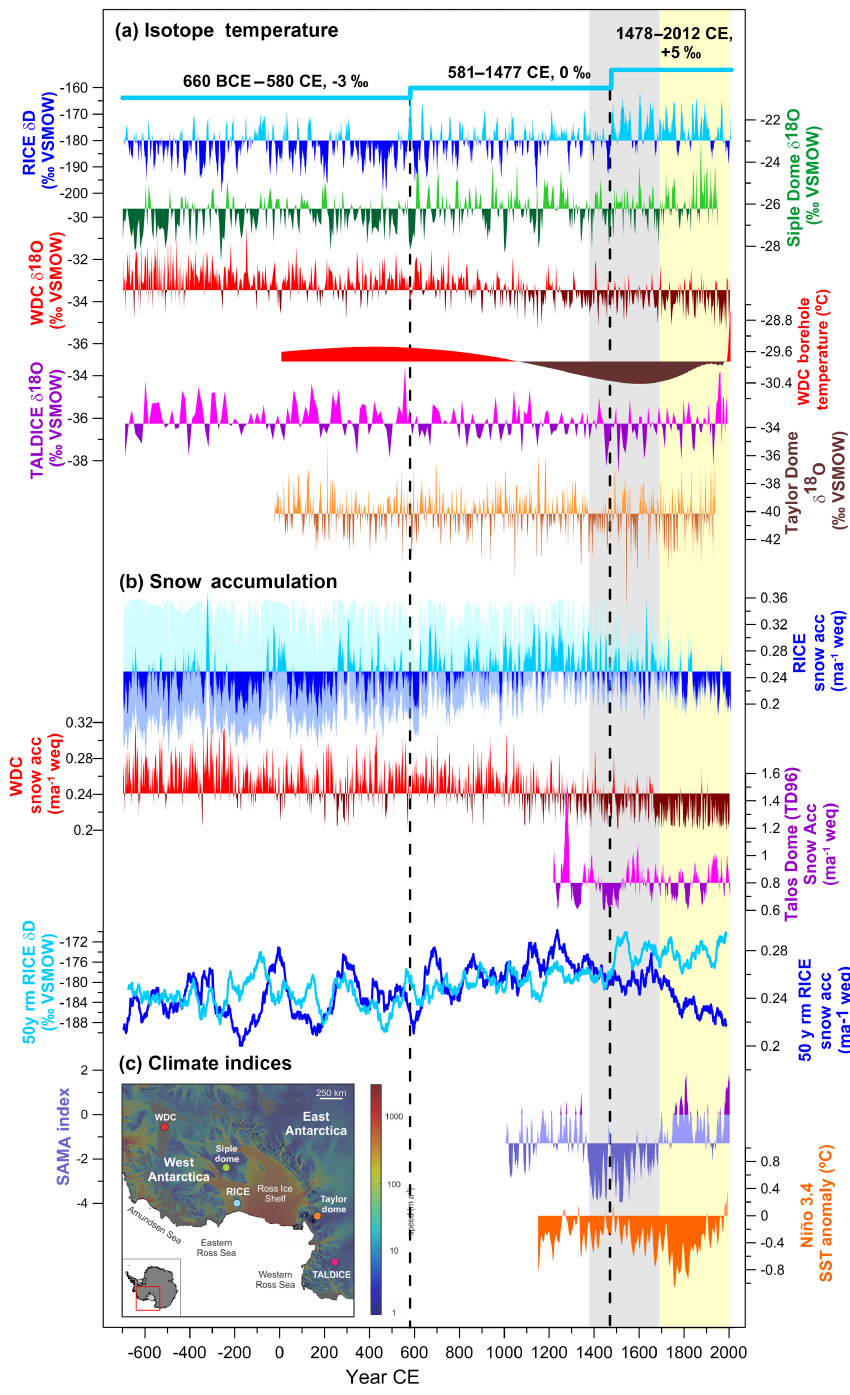
Figure 6. (a) Isotope records for the past 2700 years for RICE, Siple Dome (Brook et al., 2005), WDC (WAIS Divide Project Members, 2013), TALDICE (Stenni et al., 2011) and Taylor Dome (Steig et al., 1999, 2000; Sigl et al., 2014; PAGES2k Consortium, 2017); (b) snow accumulation data for RICE (Winstrup et al., 2017), WDC (Fudge et al., 2016) and Talos Dome (TD96). No snow accumulation data are available for Siple Dome or Taylor Dome; (c) reconstructions of climate indices for SAM A (Abram et al., 2014) and Niño 3.4 based on HadSST2 (Emile-Geay et al., 2013). Colour coding identifies above- and below-average values. Grey shaded area emphasises period of negative SAM A ; yellow shaded area emphasises period of synchronous warming at RICE, Siple Dome, WDC and TALDICE.